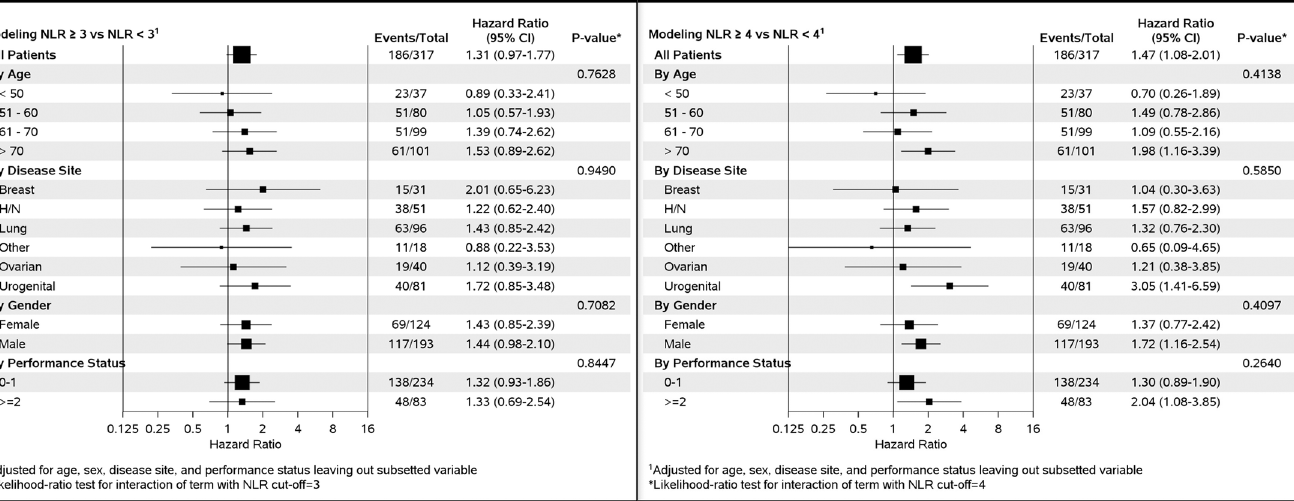
PLOS ONE | https://doi.org/10.1371/journal.pone.0195042 April 6,